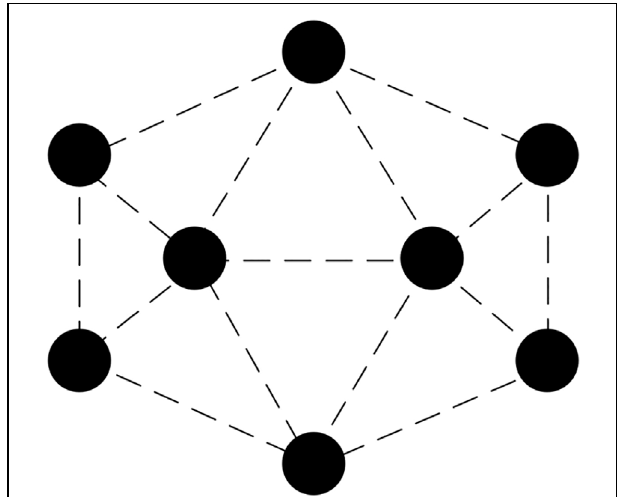
FIGURE 2 | Schematic diagram of ad hoc network